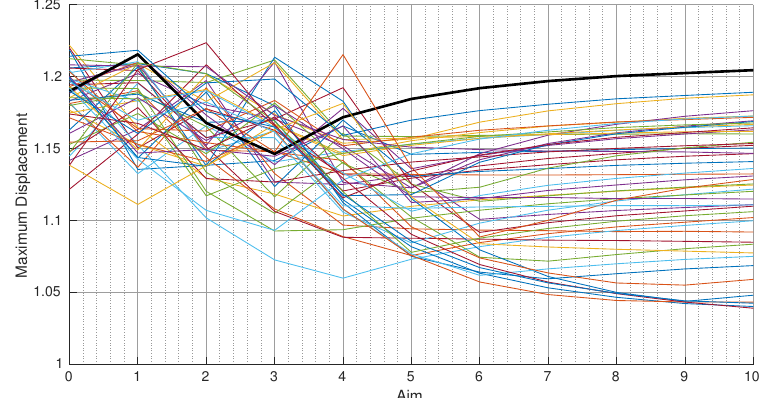
Figure 8. Maximum vibration amplitude for increasing intentional mistuning amplitude for 50 random mistuning patterns. Rotor A, [ 1, − 1, . . . ,1, − 1,1,1 ] pattern, ξ = 10 − 2 .